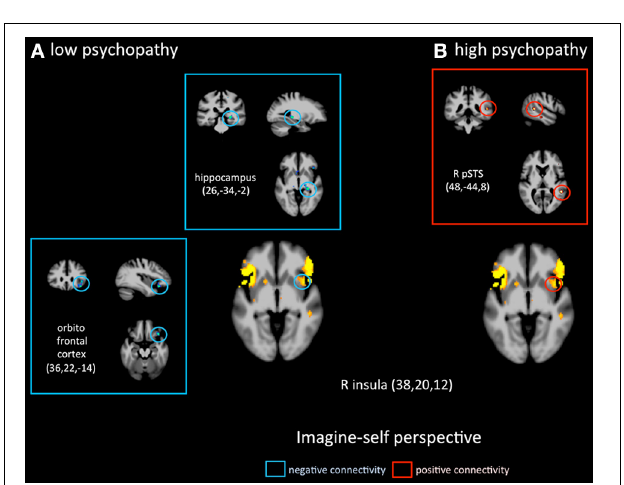
FIGURE 3 | Response in the right ventral striatum in participants scoring high on the PCL-R ( ≥ 30) when they imagined another person in pain, and correlation with scores on Factor 1.